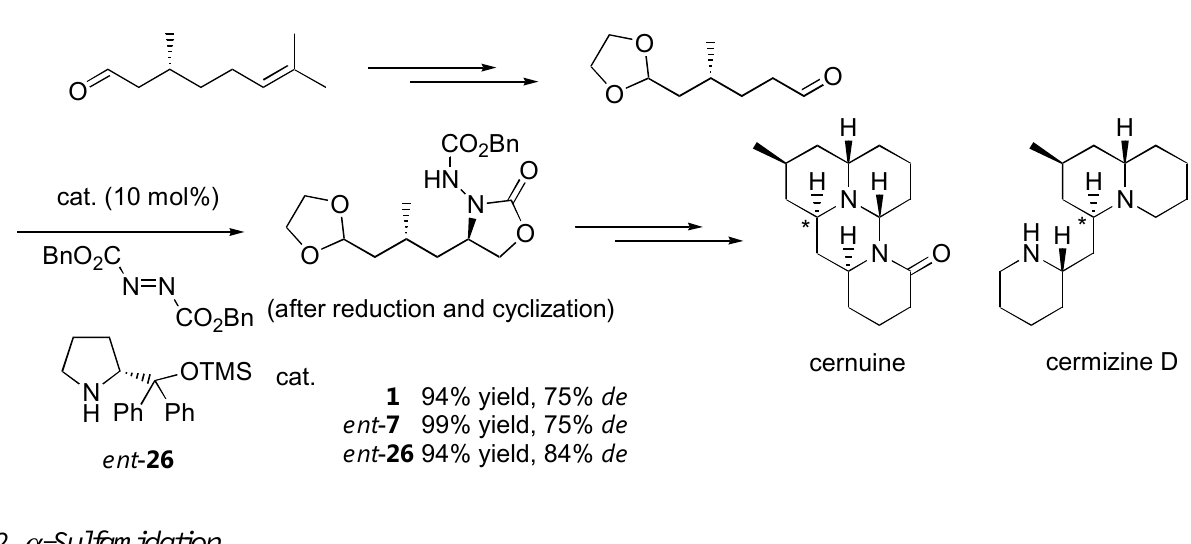
. Figure 14. Total synthesis of cernuine and cermizine D incorporating proline-catalyzed  - amination as a key step. The stereogenic centers created by the  -amination are marked by an asterisk